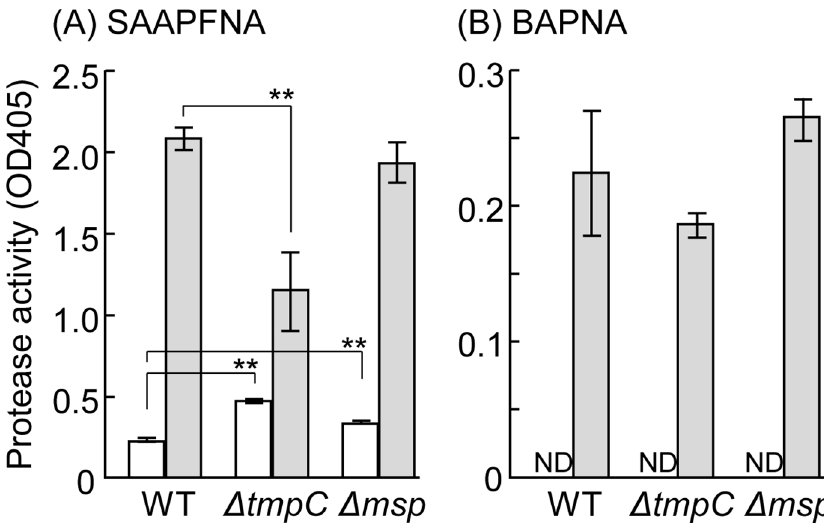
Figure 7. Protease activity assay. T . denticola cultures were separated into supernatant (white) and cell (grey) fractions, and diluted to an equivalent concentration. SAAPFNA (A) and BAPNA (B) were used as a substrate; these are typical substrates for chymotrypsin and trypsin, respectively. ND indicates that the result was below the detectable level. The data presented show a representative result from two independent experiments and are expressed as the means 6 SD (n=3). A Dunnett’s test was performed to compare the wild type and mutants (**, P , 0.01). Note that protease activities (OD 405 values) assayed using BAPNA were approximately 10-fold lower than those assayed using SAAPFNA.